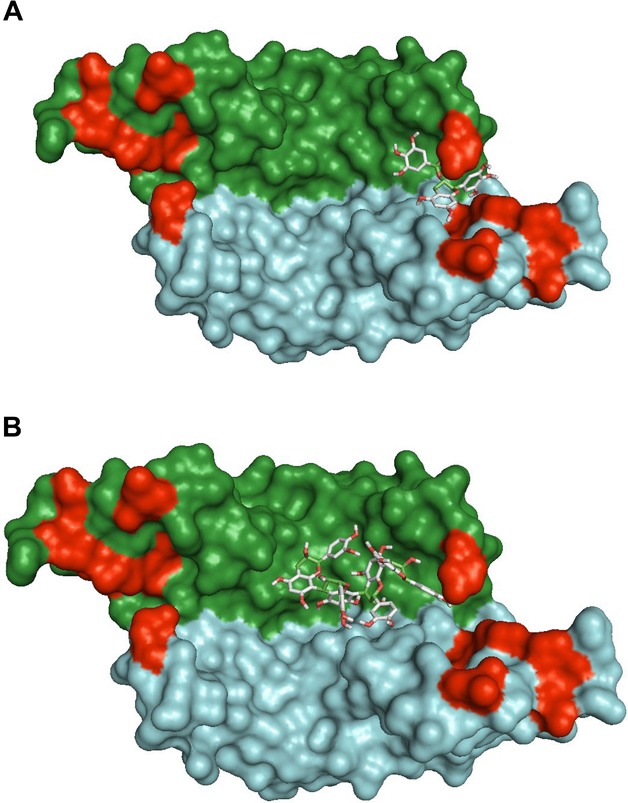
Computed highest affinity binding sites for EGCG (A) and dp4 (B) to VEGF; using AutoDock Vina v1.1.0 software. Surface representation of VEGF dimer with the individual monomers coloured in green and blue. Amino acid residues identified as important in VEGFR-2 binding (Ref 38) are coloured in red.